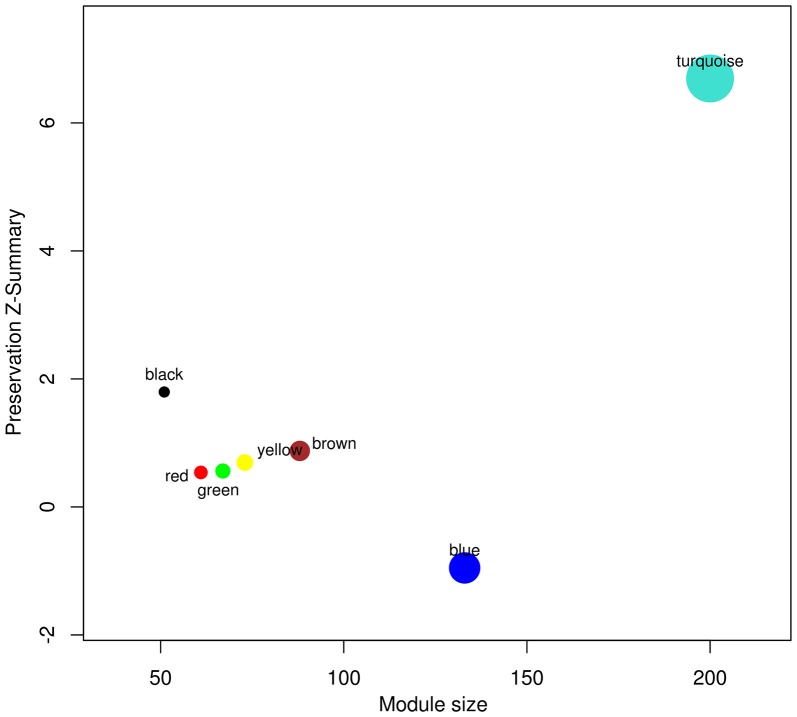
The Z-summary statistic (y-axis) of the reference (R. serpentina) data modules against test (C. roseus) network modules is plotted as a function of module size. Each circle represents a module labeled by a color and module name.